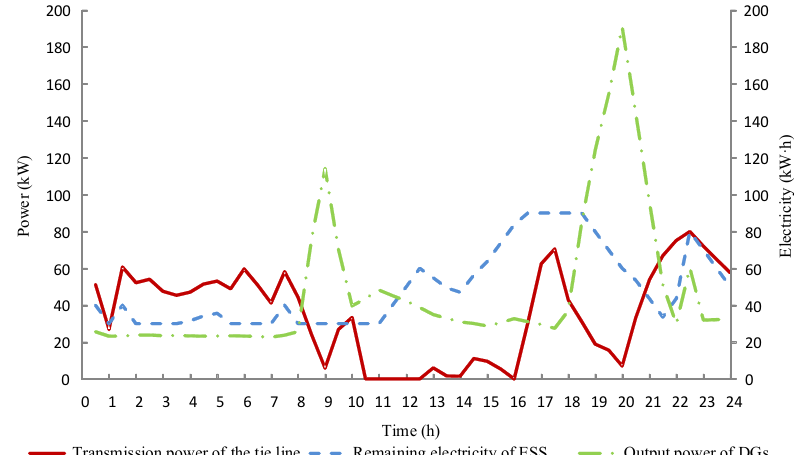
Figure 10. Optimal scheduling strategy of the typical day based on the proposed strategy.